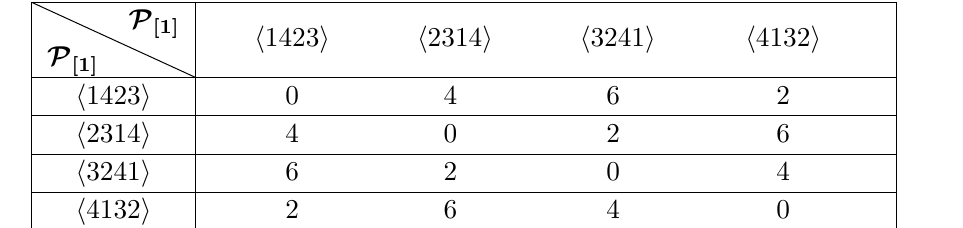
Table 1. { CM } − { CM } two-point correlator